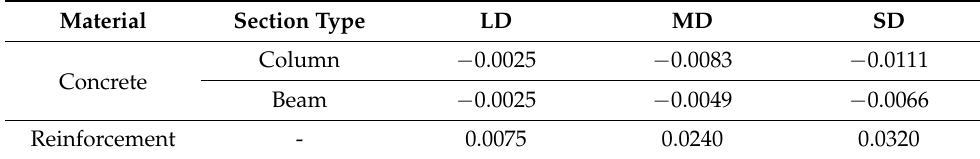
Figure 5. Idealized nonlinear models for beam and column elements [38]. Table 1. Concrete and reinforcement strain acceptance criteria for the structural members.